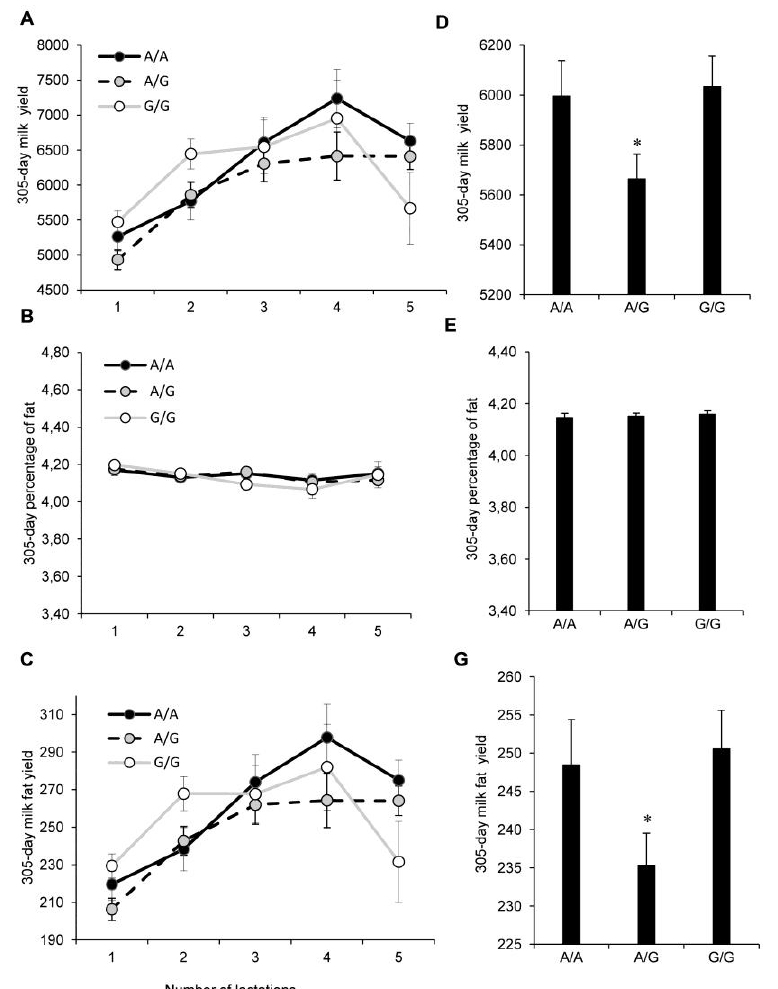
Figure 3. Data on milk performance traits in cows with different TNF  -824A/G genotypes. Data are reported as mean  SEM. A, B, C: temporal changes of 305-d milk yield, 305-d percentage of fat, and 305-d milk fat yield, respectively; D, E, F: ANCOVA results for the same traits. Number of lactations is used as a covariate and data from first to fourth lactation are combined for ANCOVA. * p<0.02 relative to the G/G group corrected for multiple comparisons using Fisher’s post-hoc LSD